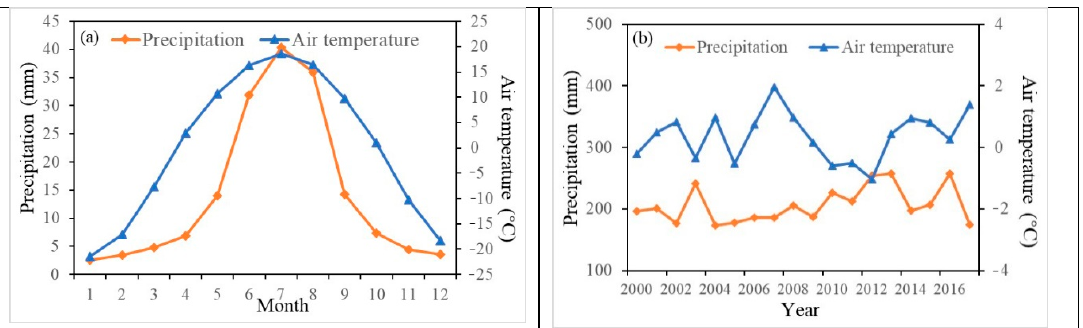
Figure 2. The monthly precipitation and monthly average air temperature ( a ), the annual precipitation and average air temperature ( b ). Values are the average of all meteorological stations.